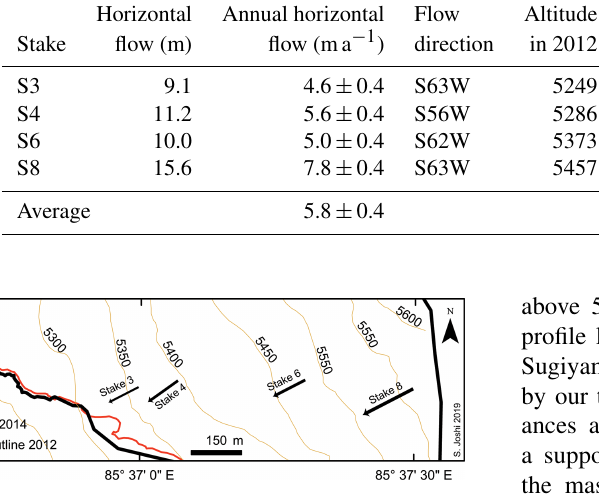
Figure 11. Glacier flow from 8 May 2012 to 5 May 2014 at stakes S3, S4, S6 and S8, with annual rates between 4.6 and 7.8ma − 1 . The black arrows show the flow direction, and the lengths indicate the annual speed of glacier surface flow, which is depicted 10 times longer than the real